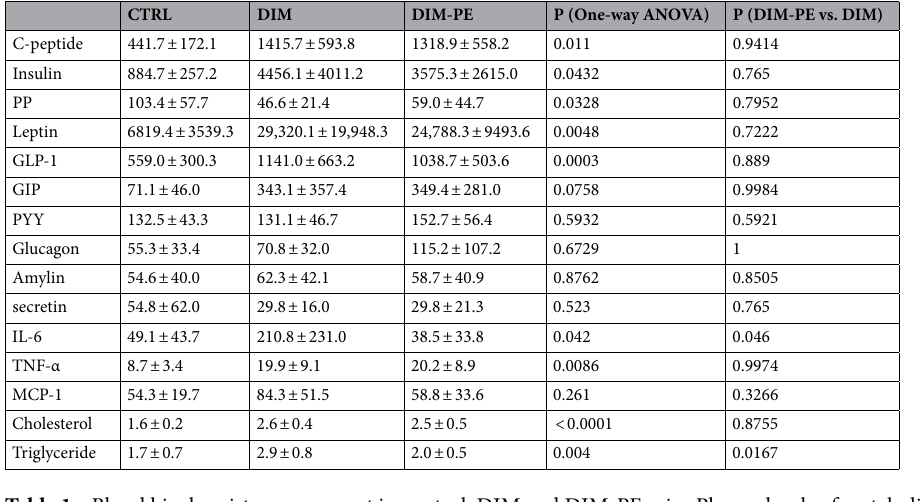
Table 1. Blood biochemistry assessment in control, DIM and DIM-PE mice Plasma levels of metabolic syndrome-associated hormones and cytokines measured at the end of the study. Data represents mean ± STDEV, n = 7–9 per